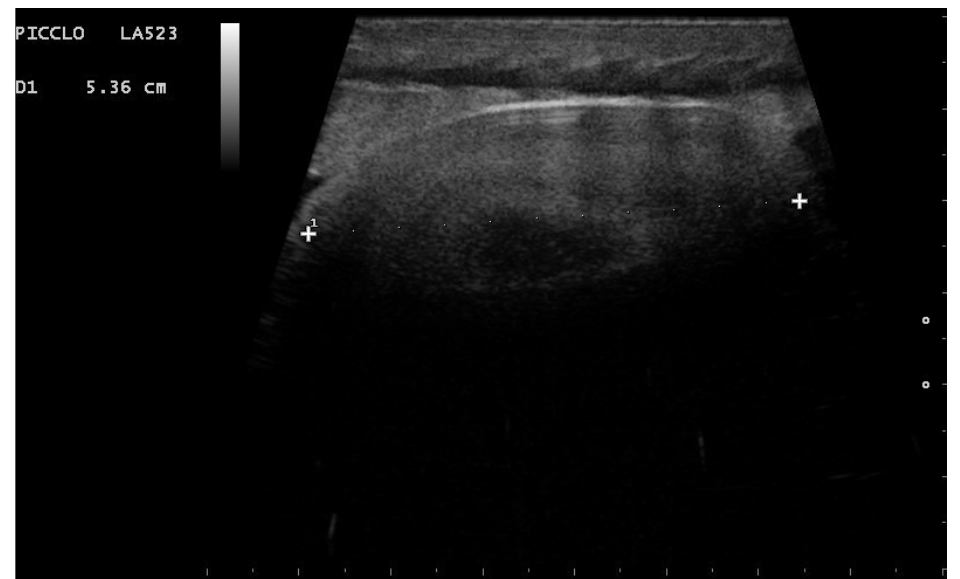
Figure 8. Post-ovulatory follicle highlighted in a female boa (32 days after ovulation). An onion ring appearance and an anechoic central area have been observed in 96.2% and 100%, respectively, of females who have given birth to living and viable offspring.